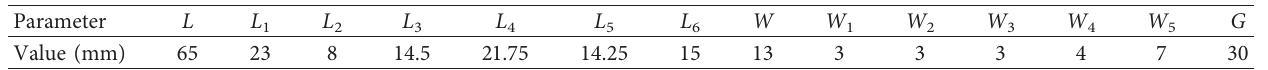
Table 1: Developed antenna’s